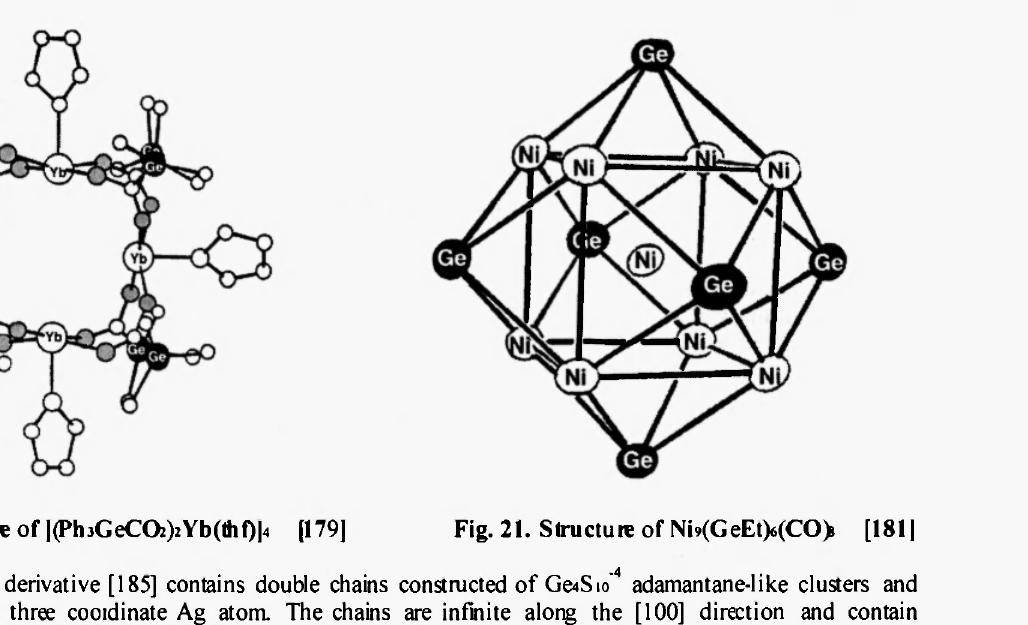
Fig. 20. Structure of |(PhjGeCa)2Yb(thO|4 [179] Fig. 21. Structure of Ni9(GeEtMCO> [181|